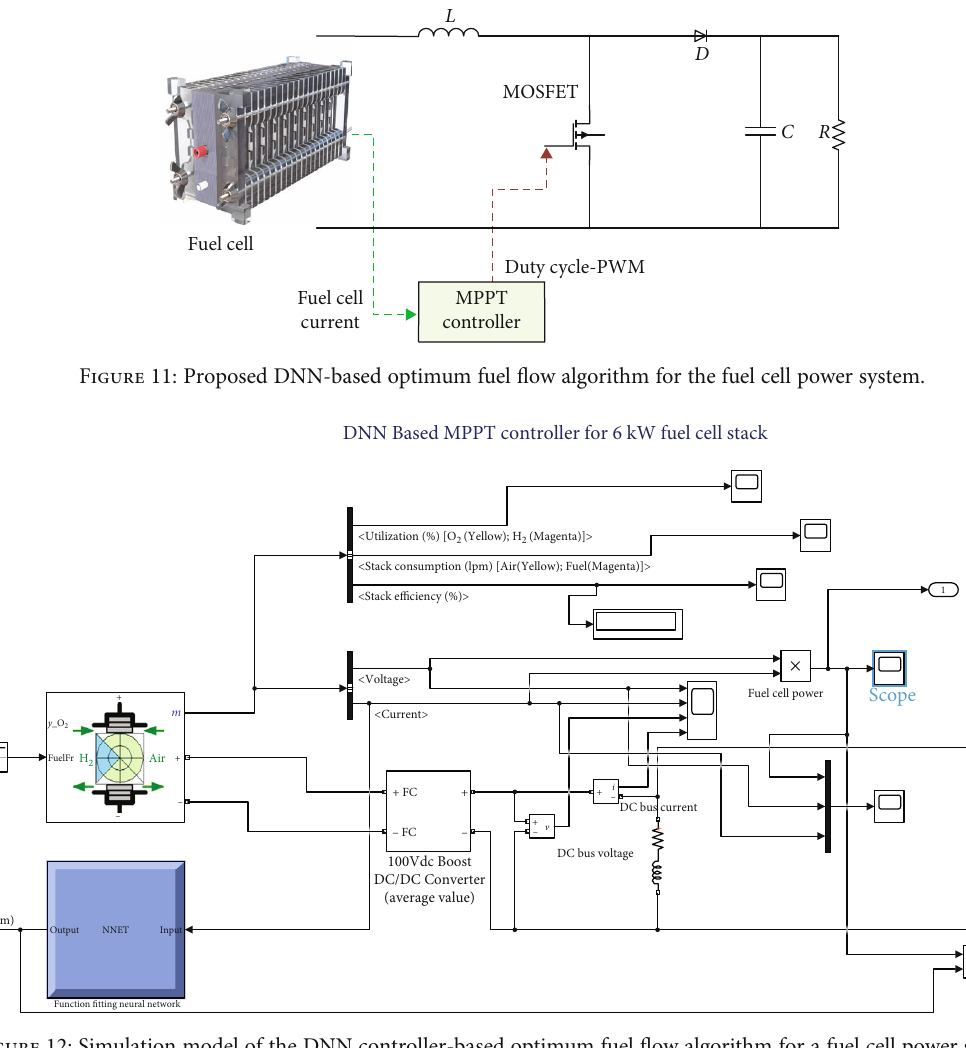
Figure 12: Simulation model of the DNN controller-based optimum fuel fl ow algorithm for a fuel cell power